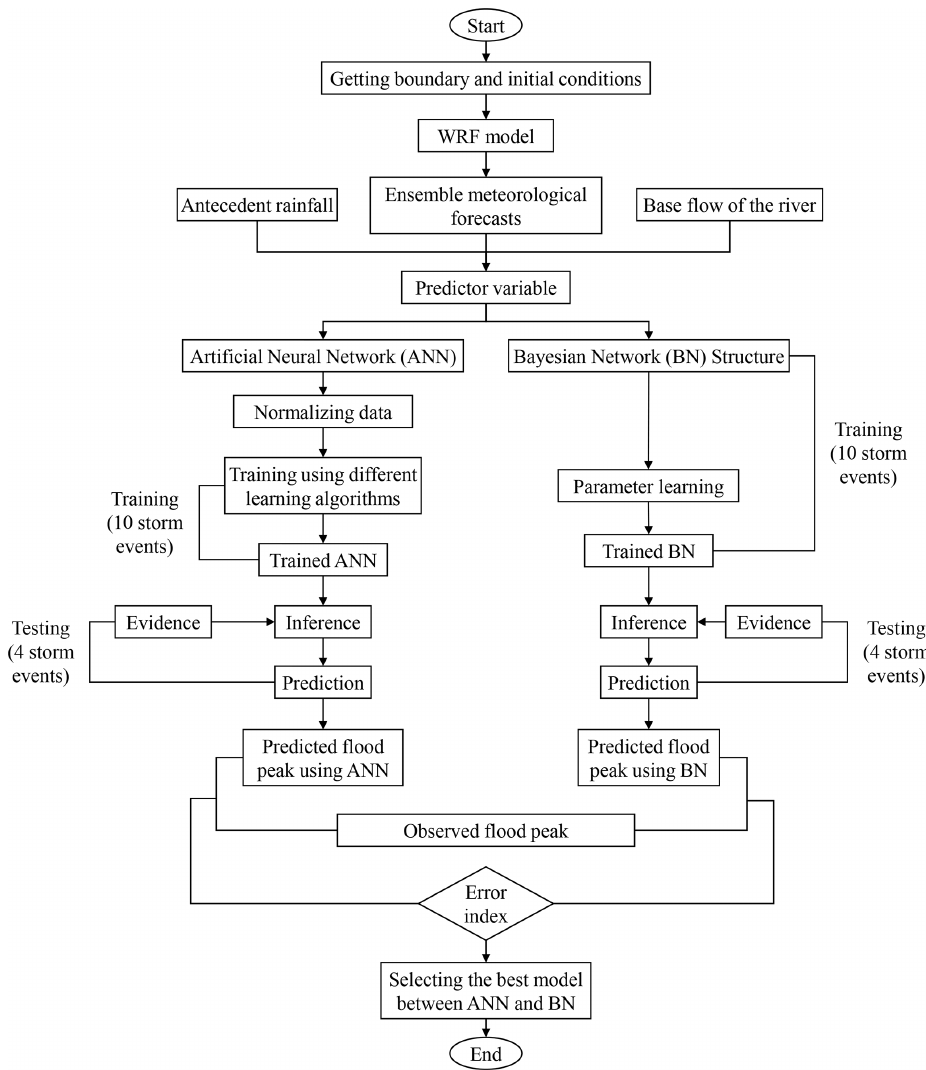
Figure 2. Flow chart of the flood forecast approach in this research.